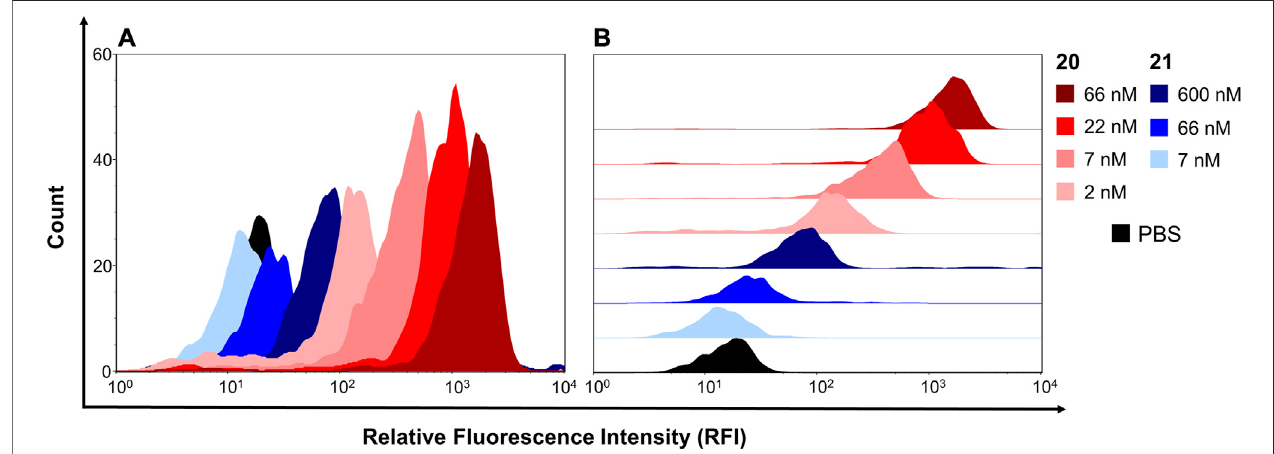
FIGURE 5 | Binding of construct 20 and construct 21 to U87MG cells, displayed as histogram (A) and half offset (B) .